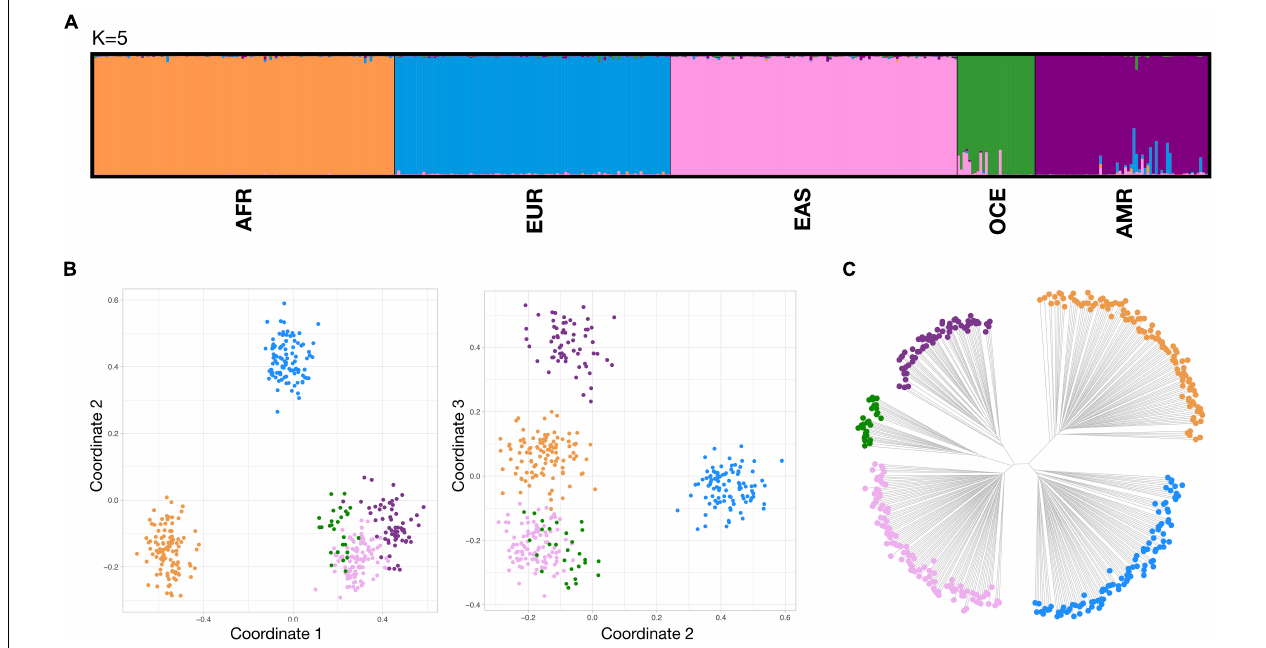
FIGURE 3 | Bio-geographical ancestry analysis of the five continental reference populations. (A) STRUCTURE results of ancestry proportions at K = 5. Each bar represents an individual and is colored in segments whose lengths correspond to their genetic cluster membership coefficients in up to five inferred population groups. (B) Three dimensional MDS analysis showing coordinates 1 and 2 (left) and 2 and 3 (right). (C) Neighbor Joining (NJ) tree analysis. For the MDS and NJ-tree plots, populations are colored according to the five different clusters which correspond to the five major populations identified in the STRUCTURE